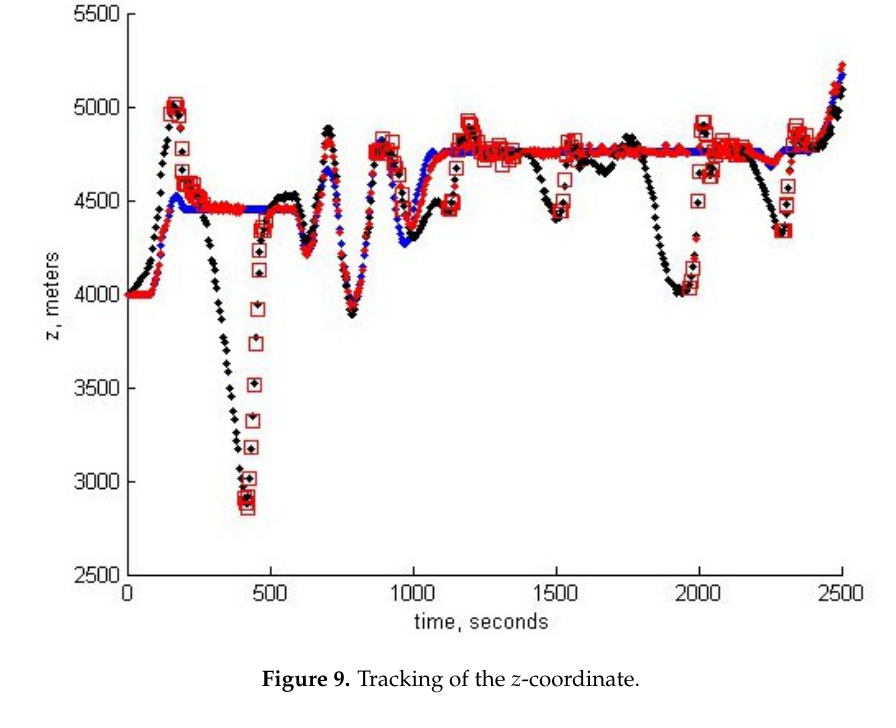
Figure 9. Tracking of the z -coordinate.